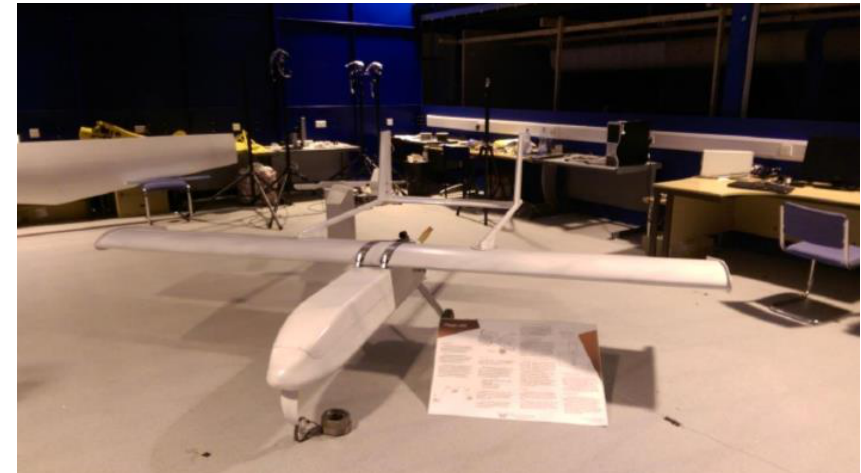
Figure 6. Photograph of model Aegis UAV with U-tail configuration at Cranfield University. The A1 sheet of paper gives an indication of model size.